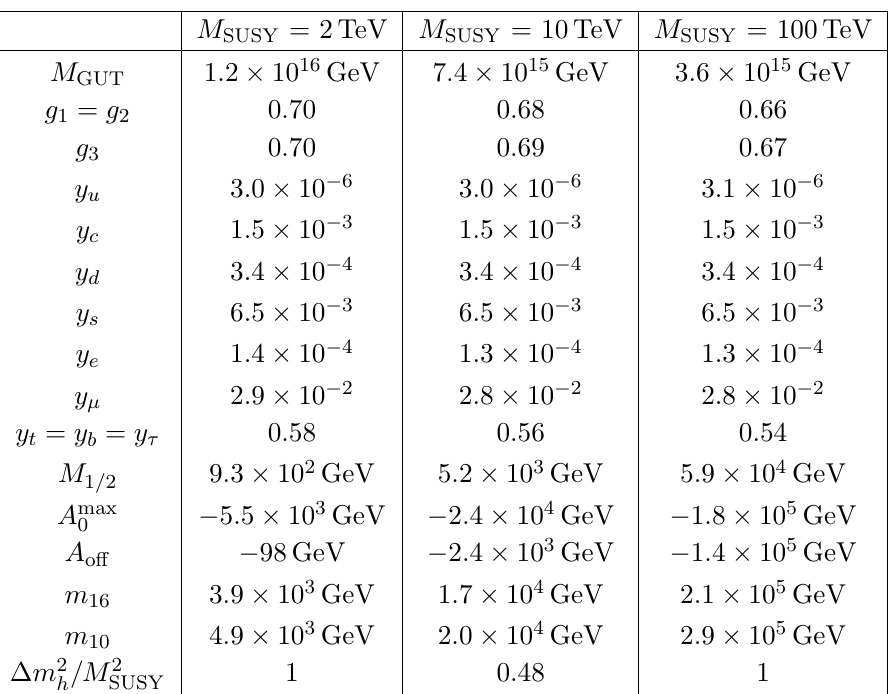
where the structure of (cid:14)A is eq. (3.7).